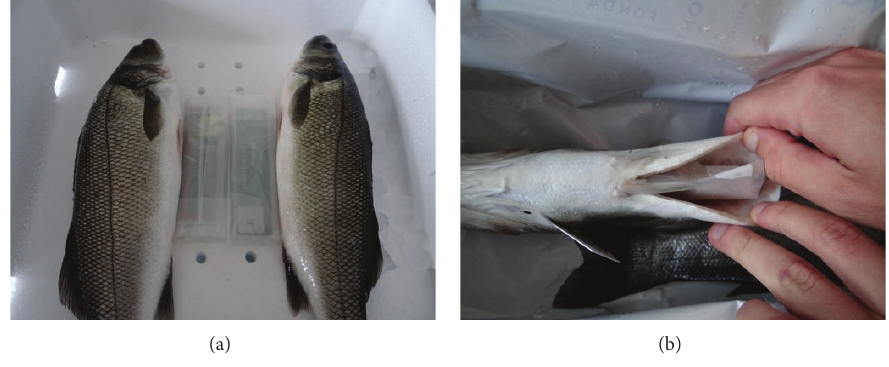
Figure 6: RFID-TL (a) in a box; (b) into the